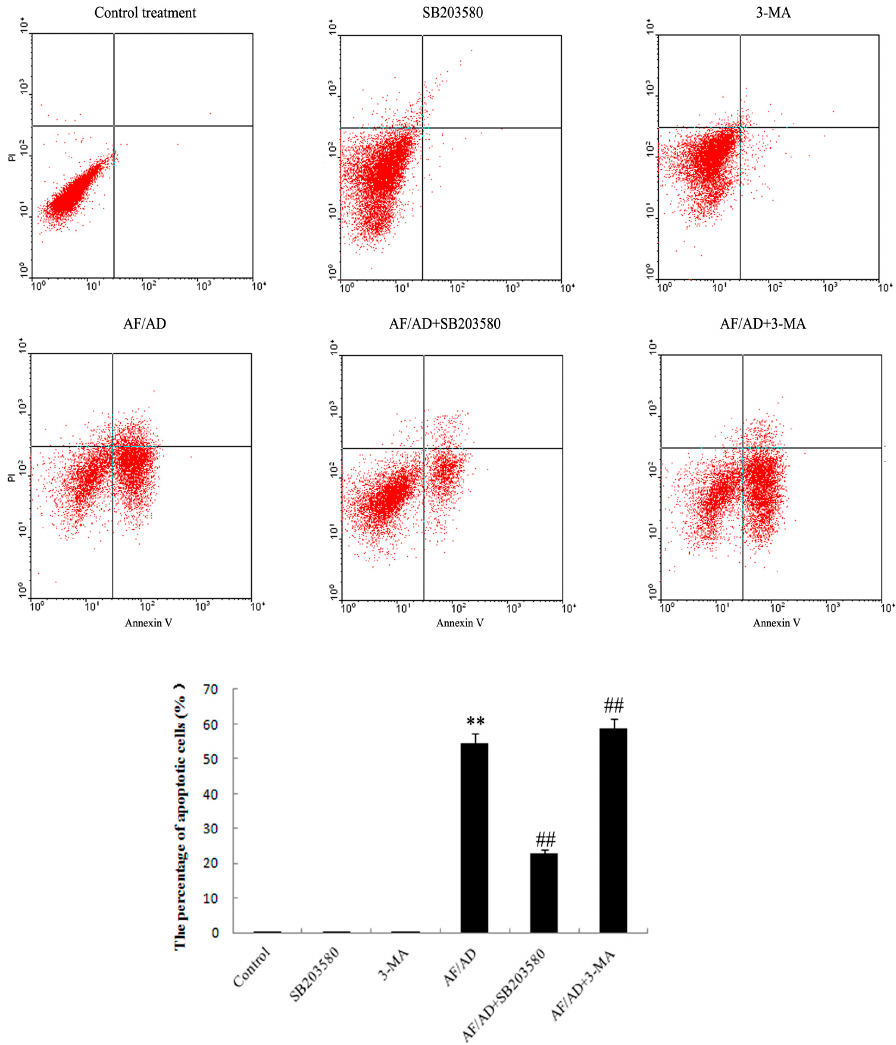
Figure 2. Effect of AF/AD on apoptosis of Bel-7402 cells with or without SB203580 or 3-MA. Bel-7402 cells were pretreated with AF (6 µ M)/AD (20 µ M) in the absence or presence of SB203580 (10 µ M) or 3-MA (5 mM) for 24 h, and then the percentage of apoptotic cells was evaluated by flow cytometry analysis of annexin V-FLUOS/PI double-stained cells. Values presented are representative of three independent experiments (means ± S.D.; ** p < 0.01, compared with control treatment; ## p < 0.01, compared with AF/AD